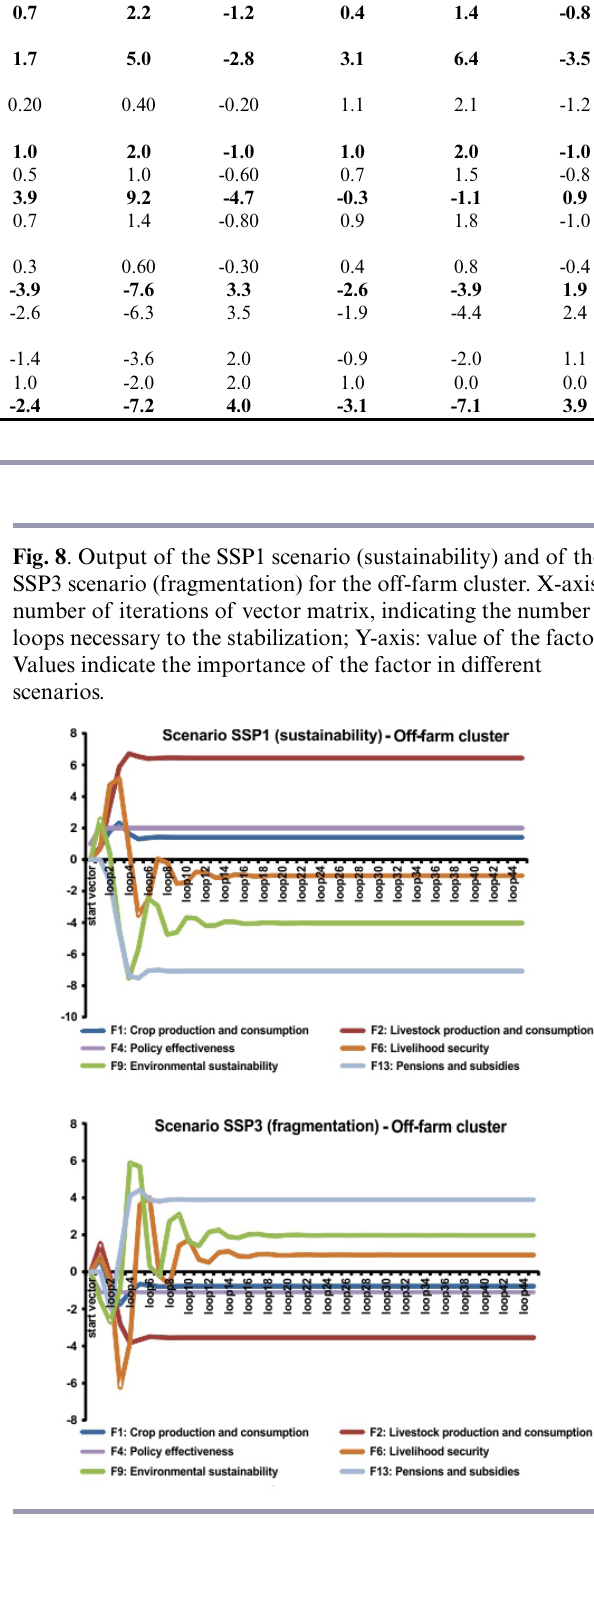
Table 6 . Final values of stabilization of the change vectors for the factors in the three fuzzy cognitive maps. Factors Livestock Diversified Off-farm Current SSP1 SSP3 Current situation situation